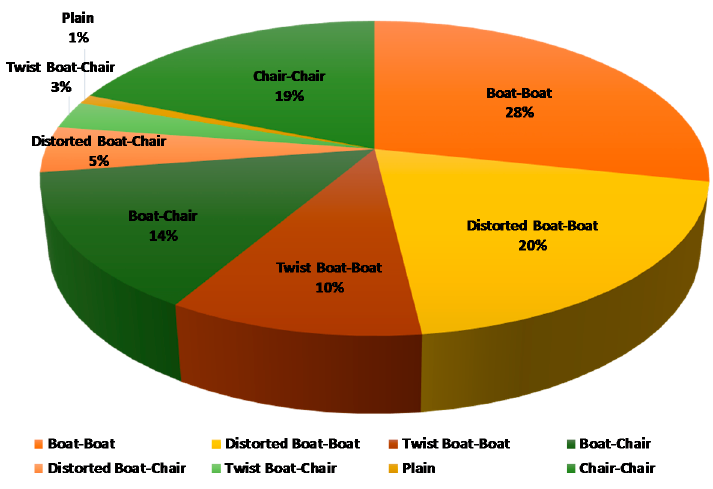
Figure 4. Conformational distribution of eight-membered [( µ 2 -dppm) 2 Cu 2 ] 2+ moieties.